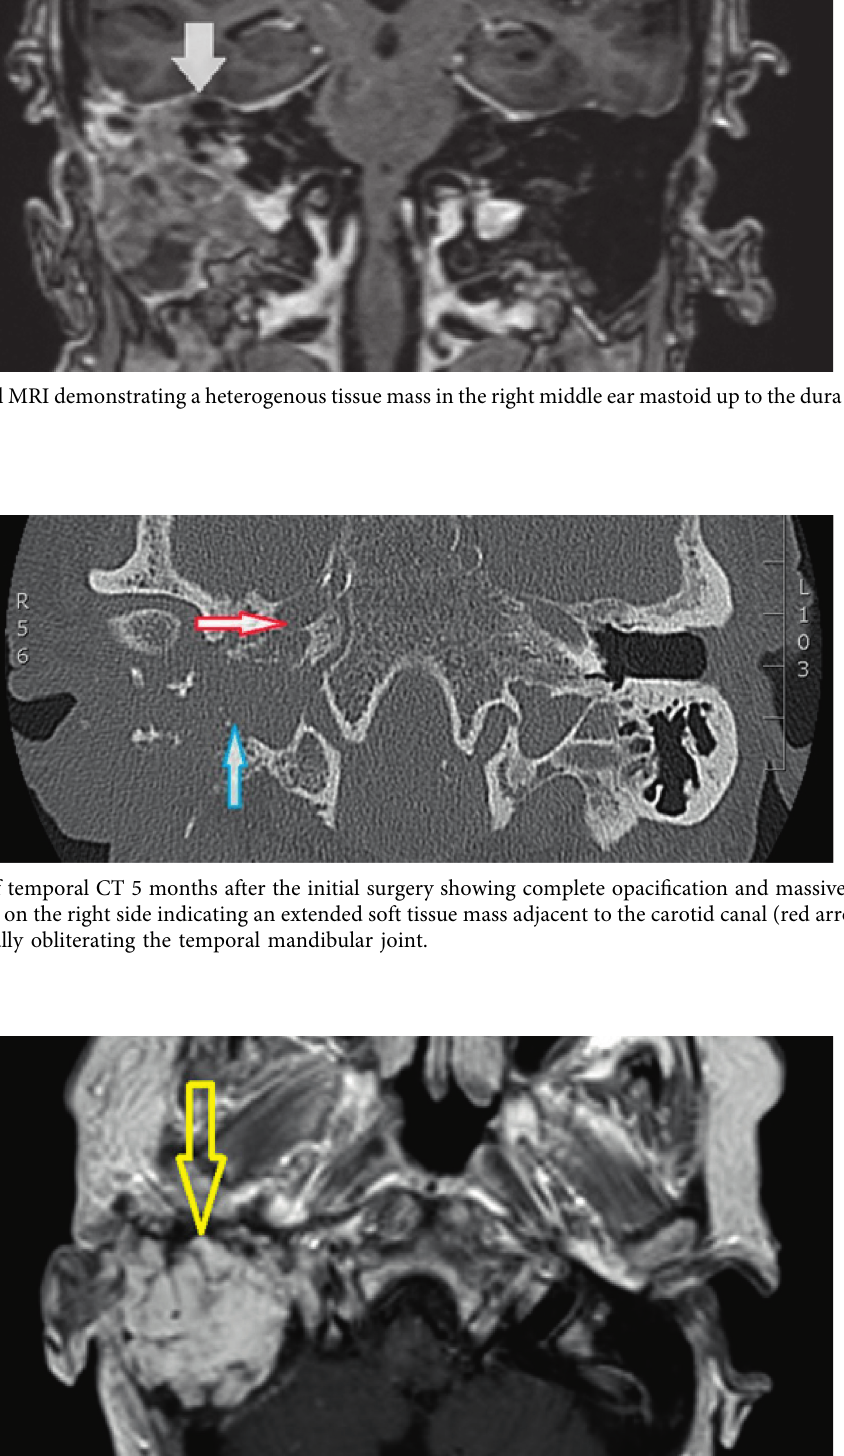
Figure 5: Axial T1-weighted MRI with gadolinium revealed obliteration with abdominal fat (yellow arrow) without any residual tumor 16 months after the extended temporal bone